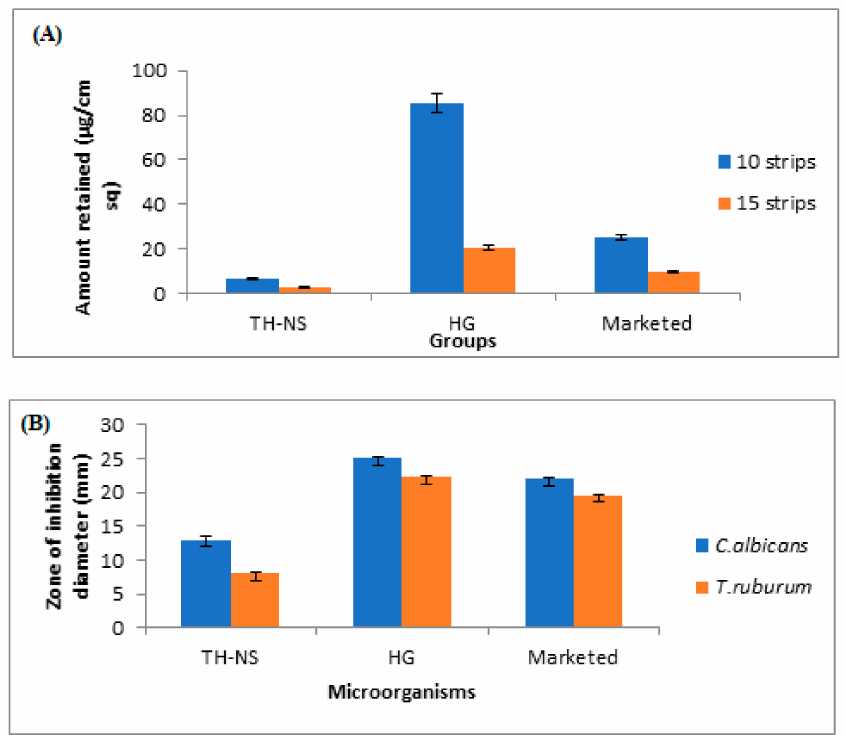
Figure 8. ( A ) Comparative amount retained by tape stripping (10 and 15 strips) and ( B ) Comparison of the zone of inhibition for the microorganisms of three di ff erent groups TH solution, TH-NS gel, and marketed